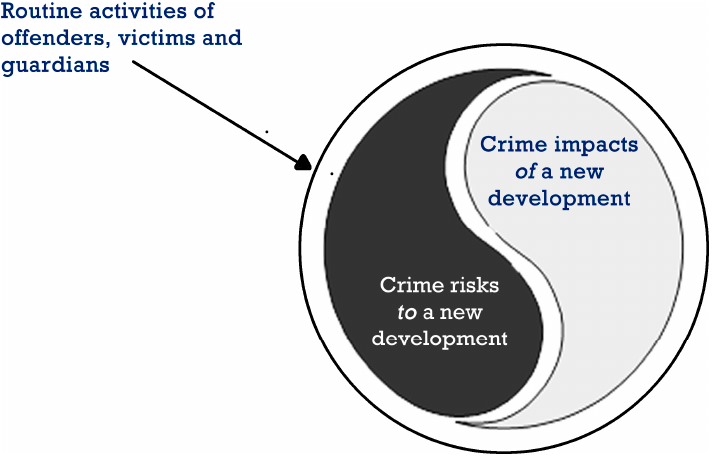
Figure 5. Crime Risks to and Crime Impacts of New Developments (Adapted from Cozens 2011).